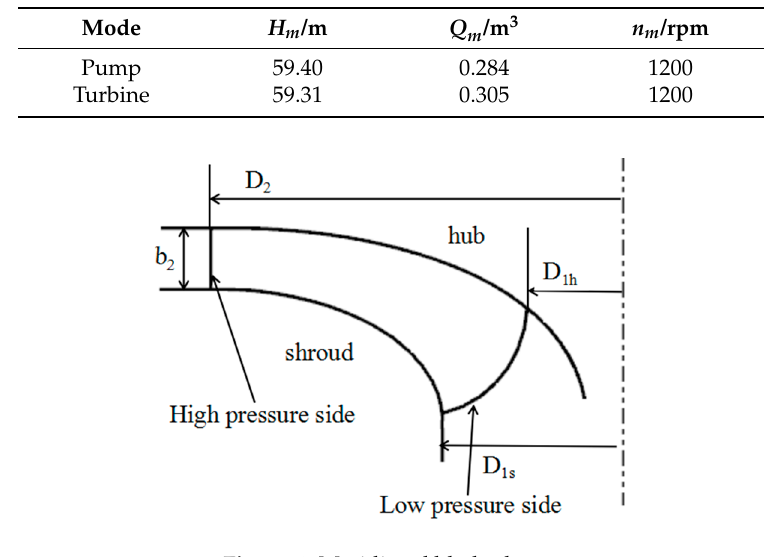
Figure 4. Meridional blade shape. Table 2. Geometric parameters for meridional blade shape